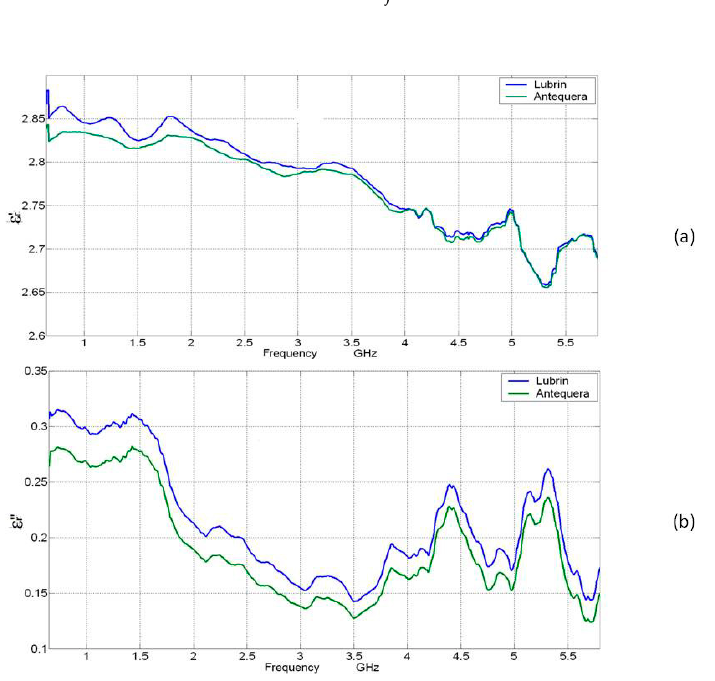
Figure 1. Relative permittivity behavior of the Lubrin and Antequera oil of the “Picual” variety type. ( a ) Dielectric constant ( ε ’); ( b ) loss factor ( ε ”).